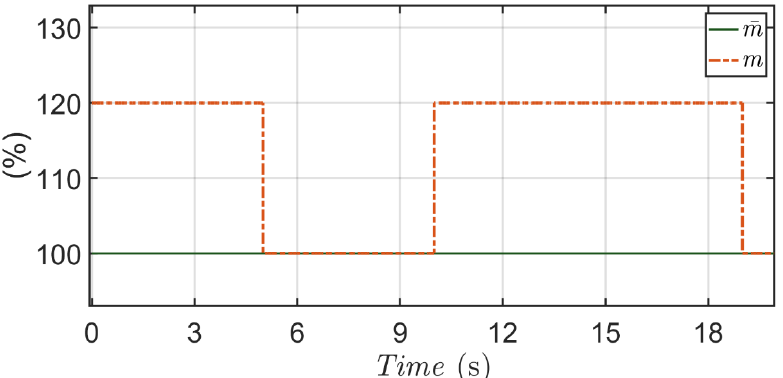
Figure 7. A time-varying positive perturbation (20% of m ) is added for m during 0 – 5 s and 10 – 19 s (red dotted line) in Scenario 1. (red dotted line) in Scenario